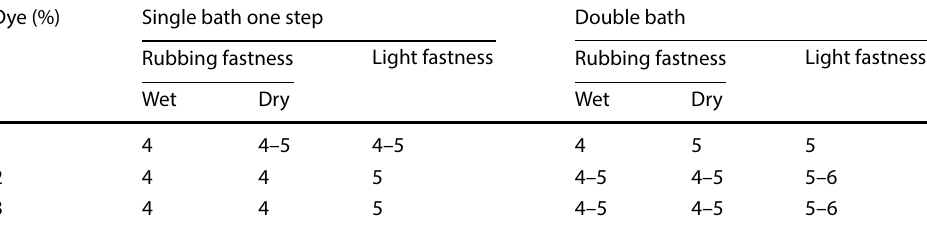
Table 6 Fastness to perspiration of modified PC blend and conventional fabric